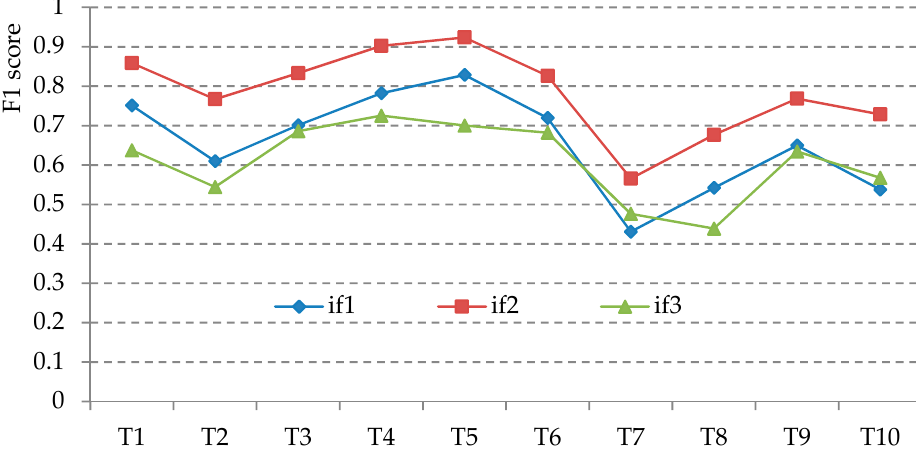
Figure 11. Average F1 scores of 12 models for 10 test data with different input features.